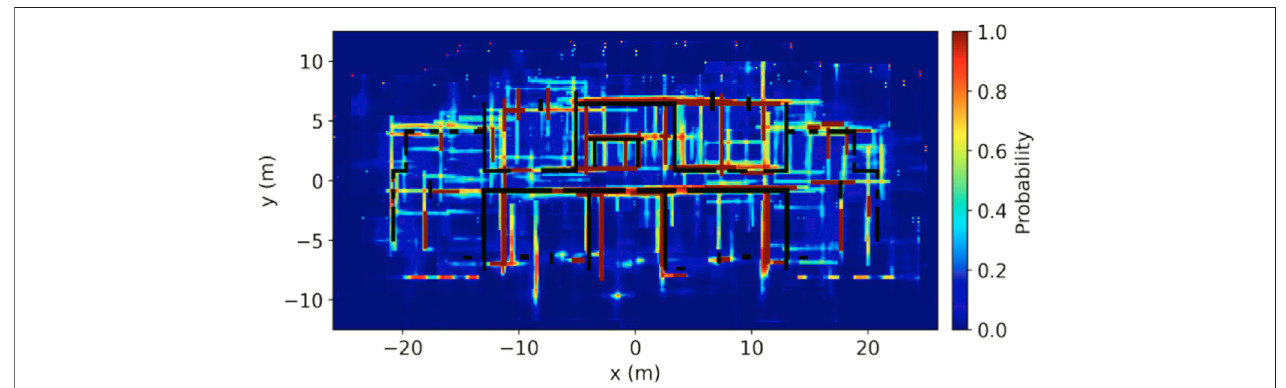
FIGURE 7 | Predicted plan obtained by Pizarro et al.